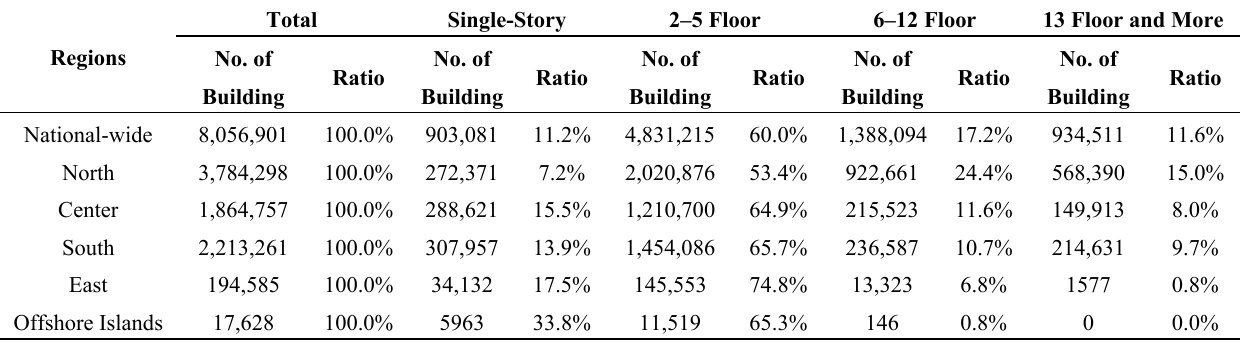
Table 5. Number of buildings in different regions for different building